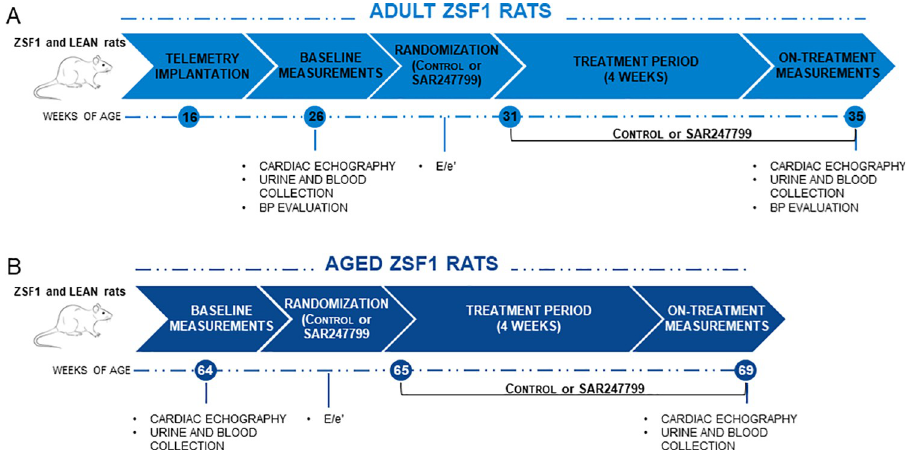
Fig 1. Overview of studies for adult and aged ZSF1 rats. Ob-ZSF1 rats were randomized on E/e’ parameter from doppler echocardiographic analysis. For adult animal study, Le-ZSF1-CTRL N = 9, Ob-ZSF1-CTRL N = 11 and Ob- ZSF1-SAR247799 N = 11. For aged animals study Le-ZSF1-CTRL N = 9, Ob-ZSF1-CTRL N = 7 and Ob- ZSF1-SAR247799 N = 7; N = number of rats.